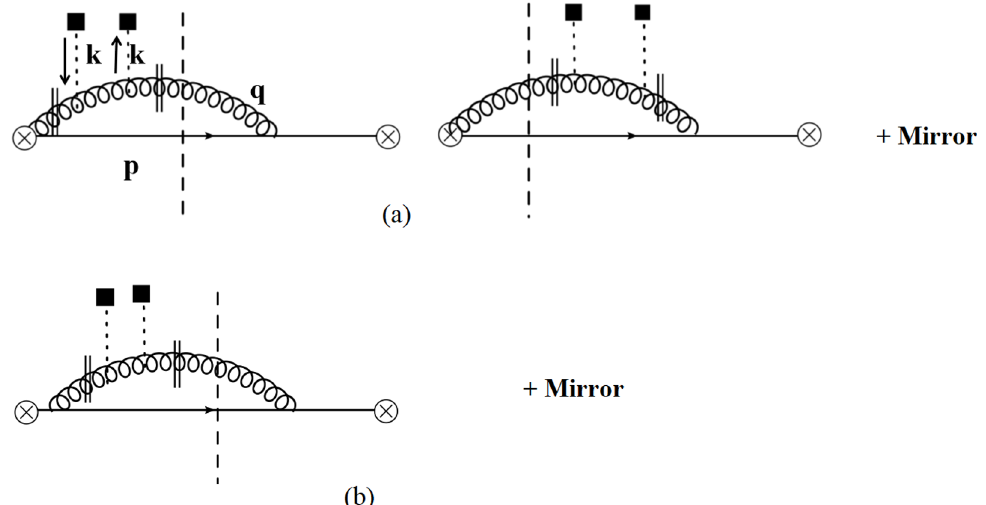
Figure 5. Gluon virtual interaction with the